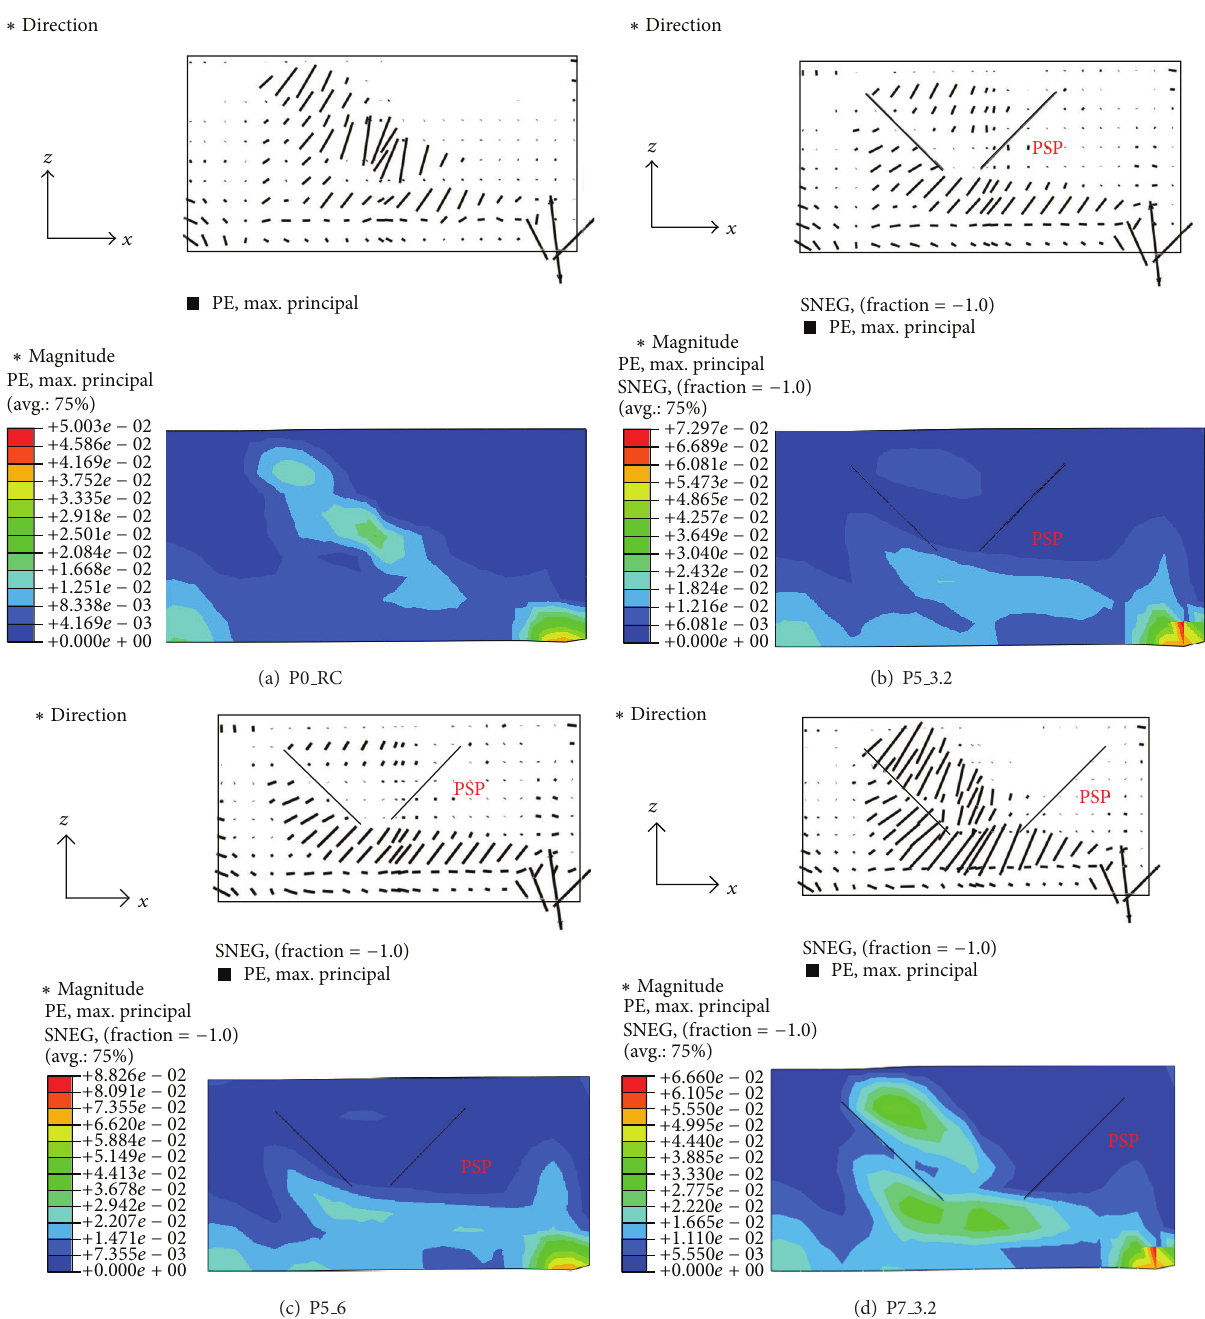
Figure 15: Crack patterns of the test specimens: (a) P0 RC; (b) P5 3.2; (c) P5 6; and (d) P7